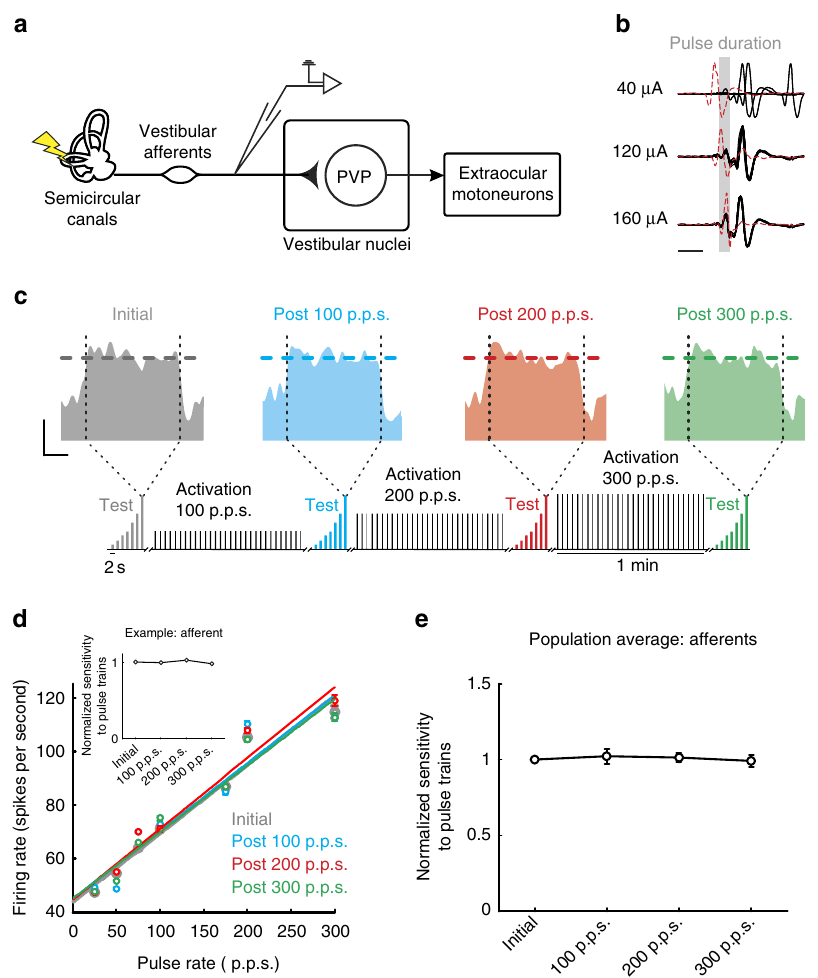
Figure 3 | Responses of vestibular afferents remain constant following activation. ( a ) Diagram of direct VOR circuitry. ( b ) Potentials recorded from single afferent fibres in response to single pulses delivered at different current amplitudes. Red traces indicate trials during which the neuron failed to fire an action potential because the pulse occurred during its refractory period. Calibration bar, 1ms. ( c ) Firing rate before (grey) and after activation of the vestibular nerve with rates of 100 (blue), 200 (red) and 300p.p.s. (green) in response to test stimuli delivered at 300p.p.s. Note that the response of the neuron remains constant. Inset shows schematic of electrical stimulation protocols. Calibrations bars, 50 spikes per s, 0.25s. ( d ) Plot of firing rate as a function of pulse rate for example neuron before and after activation of the vestibular nerve. Inset shows normalized sensitivity (slope of firing rate versus pulse rate) for example afferent. ( e ) Population average of normalized sensitivity for vestibular afferents ( n ¼ 7). Error bars represent ±